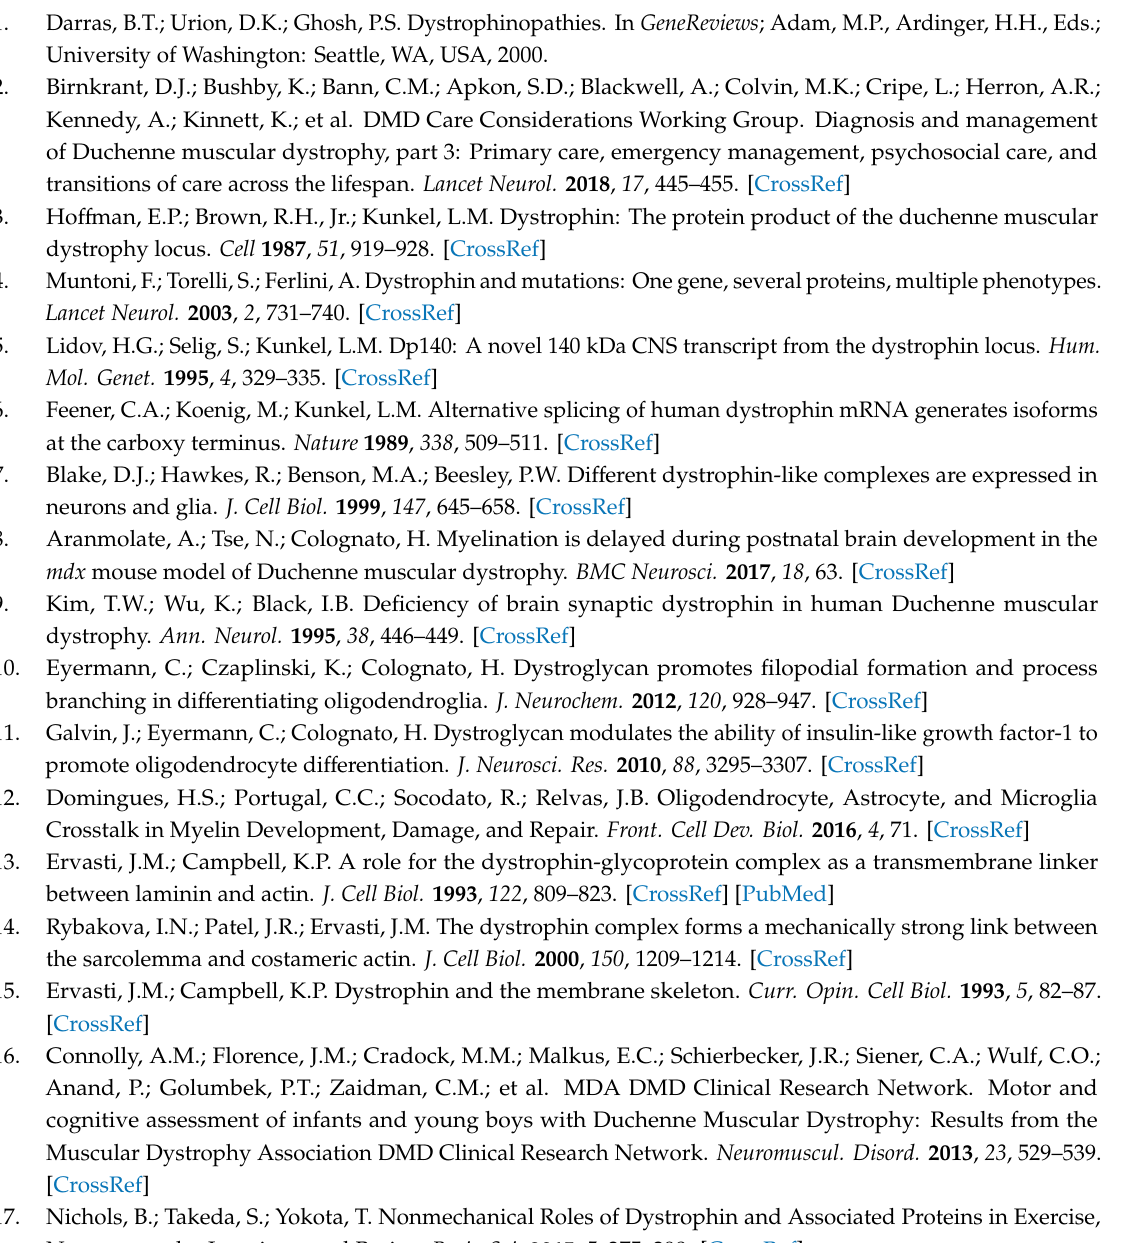
Supplementary Table S1. Co-investigators from Study PTC124-GD-007-DMD, Supplementary Table S2. The Clinical Evaluator Training Group for Study